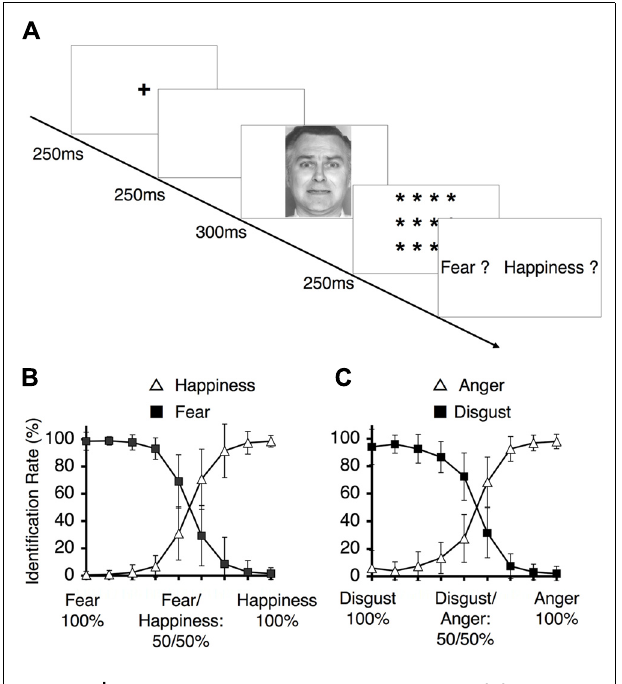
FIGURE 4 | Behavioral results for the identification task. (A) The experimental design for the identification task. Subjects were asked to identify a depicted facial expression by choosing between the two emotions at the endpoints of the continuum to which the depiction belonged (i.e., fear vs . happiness, or disgust vs. anger). (B) The identification rates for the happiness − fear continuum.These rates indicate the frequencies at which happiness and fear were identified for the morphed faces depicted in Figure 2A . (C) The identification rates for the anger–disgust continuum.These rates indicate the frequencies at which anger or disgust were identified for each of the morphed faces depicted in Figure 2B (as indicated by the labels along the x -axis).